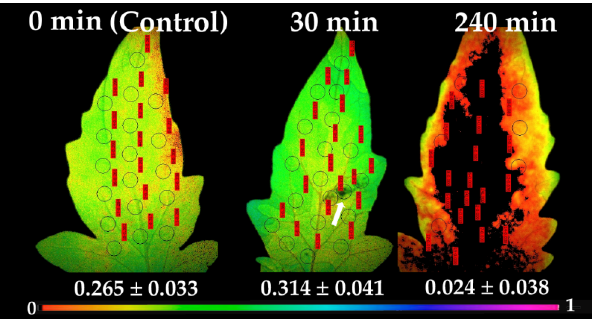
Figure 6. Chlorophyll fluorescence images of Φ PS ΙΙ , measured at 640 μ mol photons m − 2 s –1 , before (0 min, control) and after 30 and 240 min of B. cinerea suspension application on tomato leaflets. The color code depicted at the bottom ranges from values 0.0 to 1.0. The circles in each image denote the areas of interest (AOI) that were selected in each leaflet and are complemented by red labels with their Φ PS ΙΙ values, while whole leaflet value is presented. Arrowhead at Φ PS ΙΙ image after 30 min of B. cinerea suspension application points at the visible area of the aquatic spore suspensions.